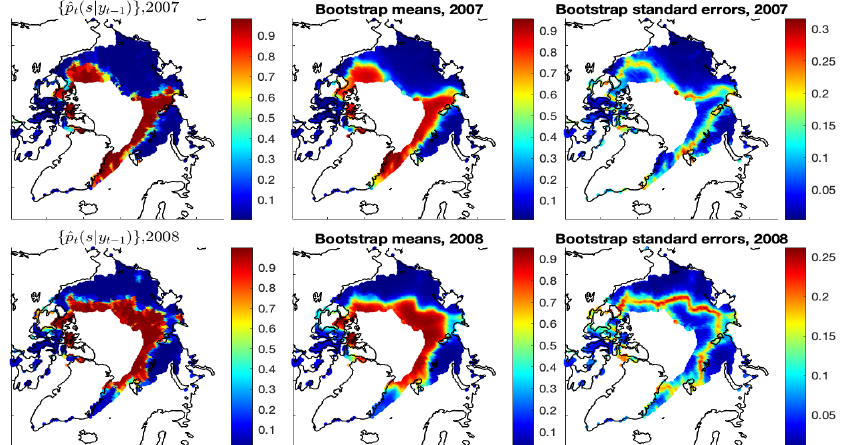
Figure A9. Years 2007 and 2008 are shown. Left panels: The estimates { ˆ p t ( s i | y t − 1 ) } of Model-1c. Middle panels: The bootstrap means of the estimated ice probabilities from 100 bootstrap samples. Right panels: The bootstrap standard errors of the estimated ice probabilities.